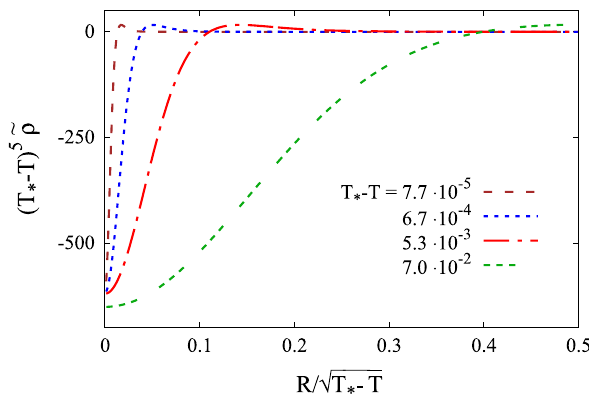
Fig. 8 Energy density of the collapsing Q-ball for Ω in = 0 . 6 at